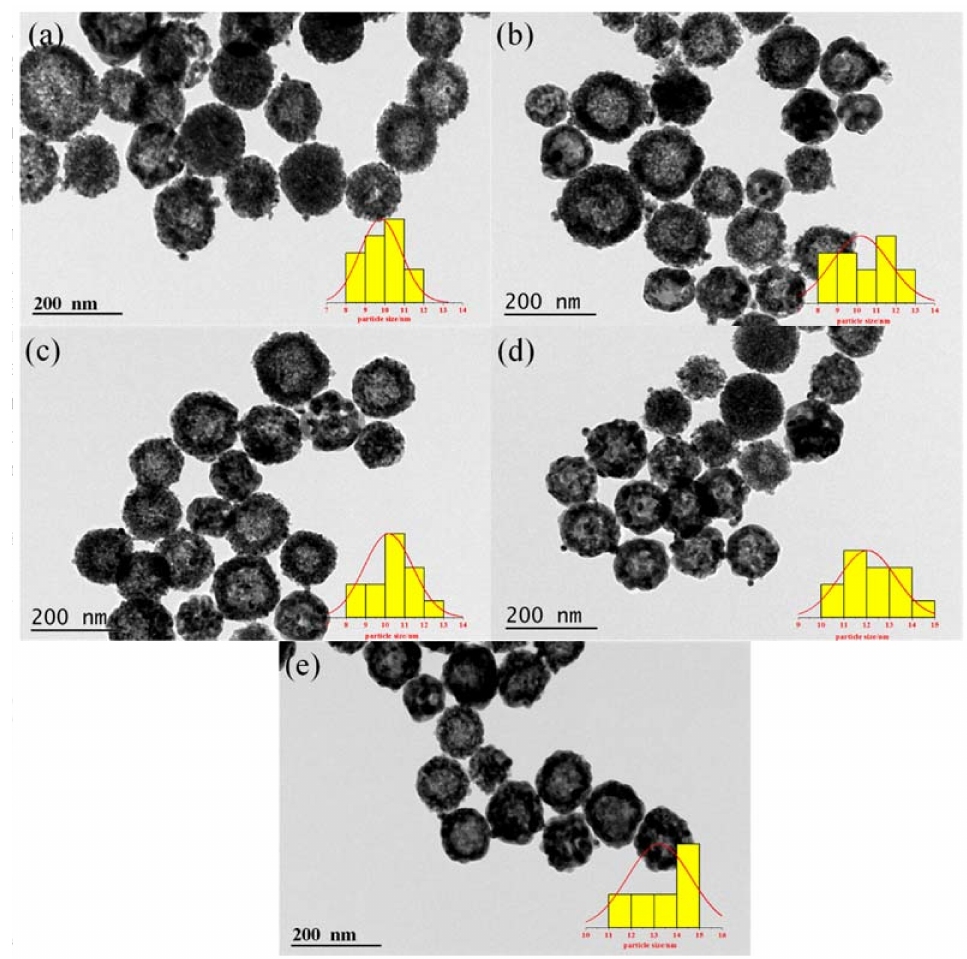
Figure 4. Transmission electron microscope (TEM) images of Au-CeO 2 samples and the corresponding size distribution of the Au NPs. ( a ) AC-3-H, ( b ) AC-6-H, ( c ) AC-9-H, ( d ) AC-12-H and ( e ) AC-24-H.